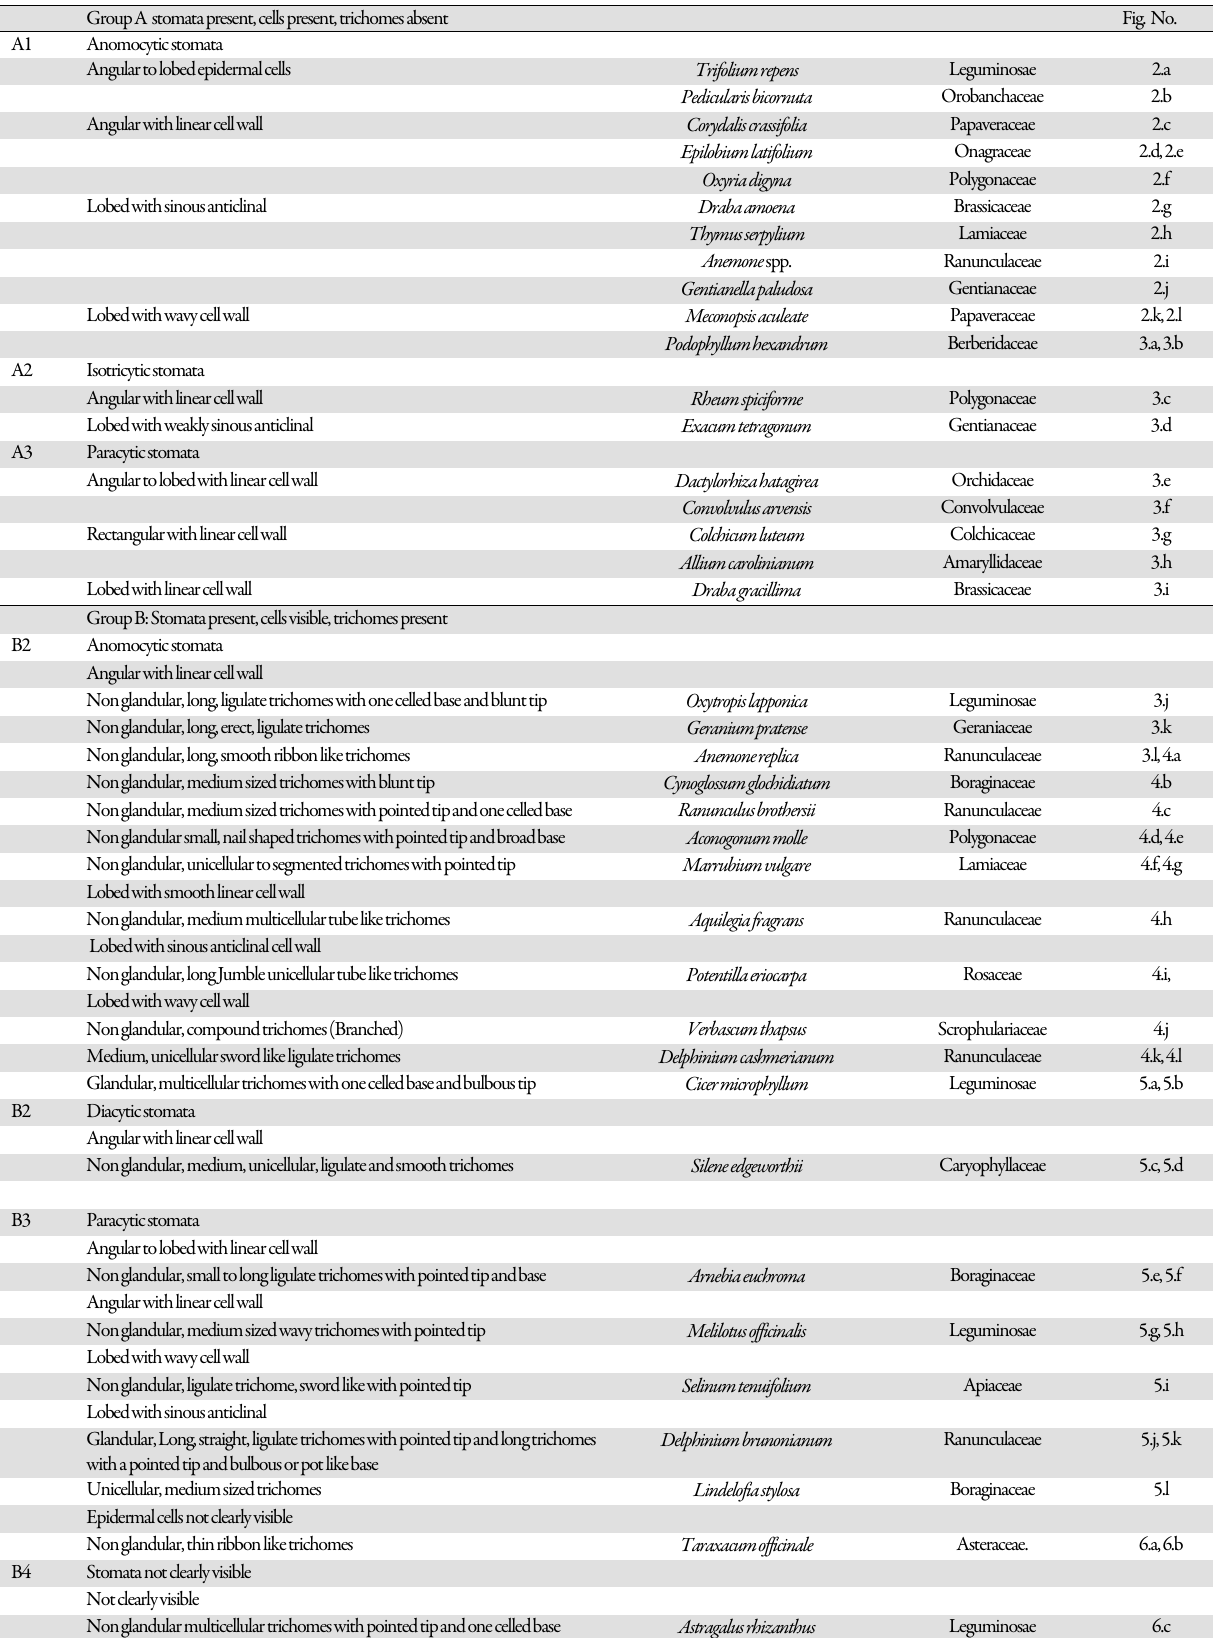
Table 1. Identification key of some plants of Kargil, Indian